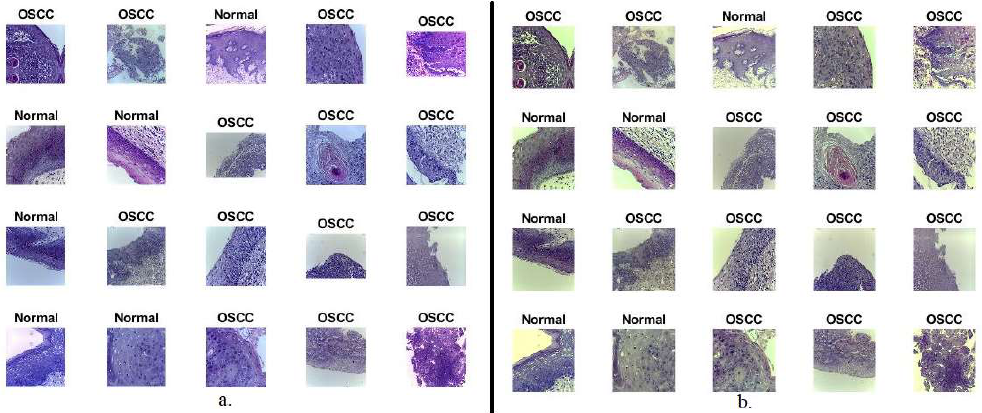
Figure 2. Samples of histopathological images of OSCC. ( a ) Original images before the enhancement process; ( b ) optimized images after the enhancement process. process; ( b ) optimized images after the enhancement